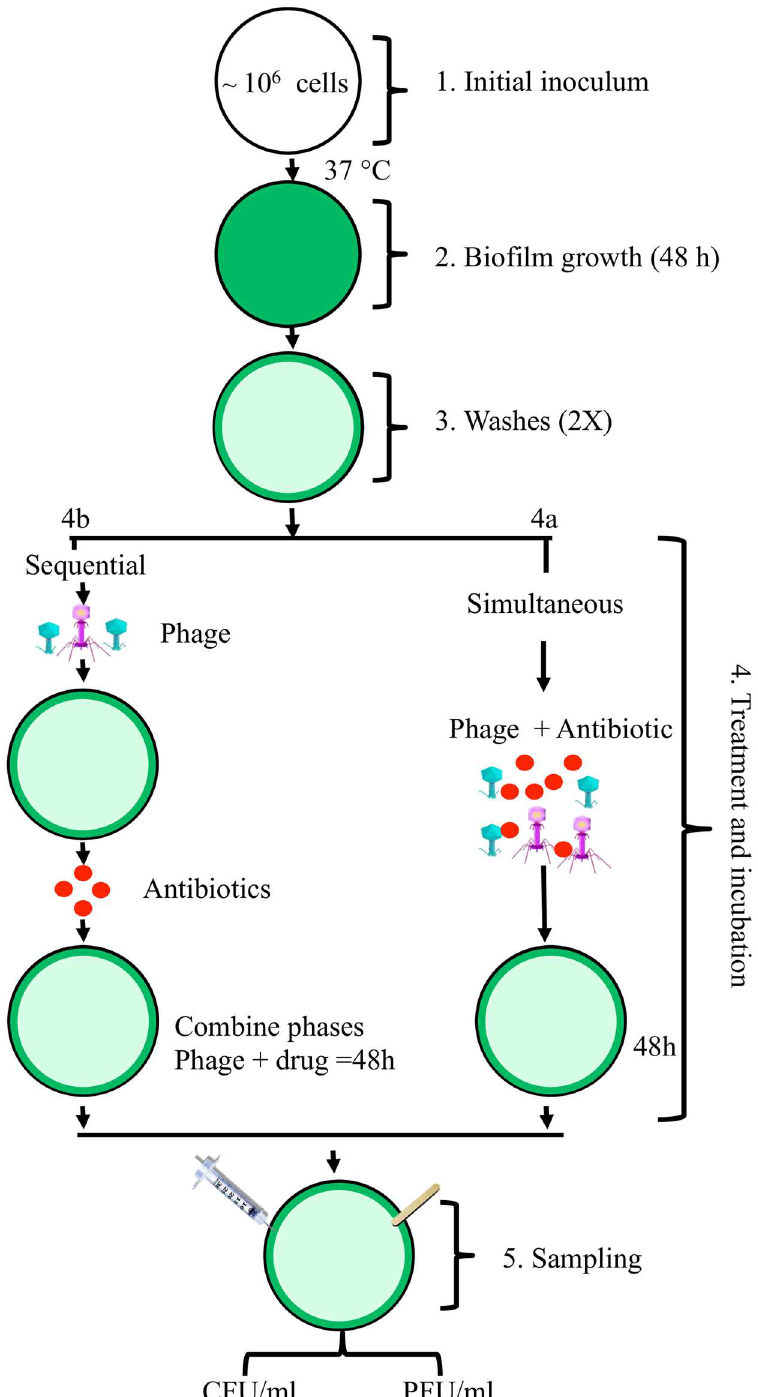
Fig 2. Schematic representation of the in-vitro procedure used to quantitatively explore the efficacy of antibiotics and phage for treating biofilm populations of bacteria. (1) The biofilms were established by inoculating 1 X10 6 cells/mL in 2 mL LB in 24 well polystyreneplates. (2) These cultures were incubatedfor 48 hours without shakingto establishthe biofilm. (3) The planktonic cells were removedwith aspirator and wells were washedtwice with saline. (4) These biofilm cultures were treated in one of two ways, (4a) Fresh LB with the phage(10 6 PFU/mL and antibiotics were simultaneously added to the wells. (4b) Fresh LB with the phage mixture (10 6 PFU/mL) was addedfirst and then antibiotics were added with a delay of 4 or 24 hours.